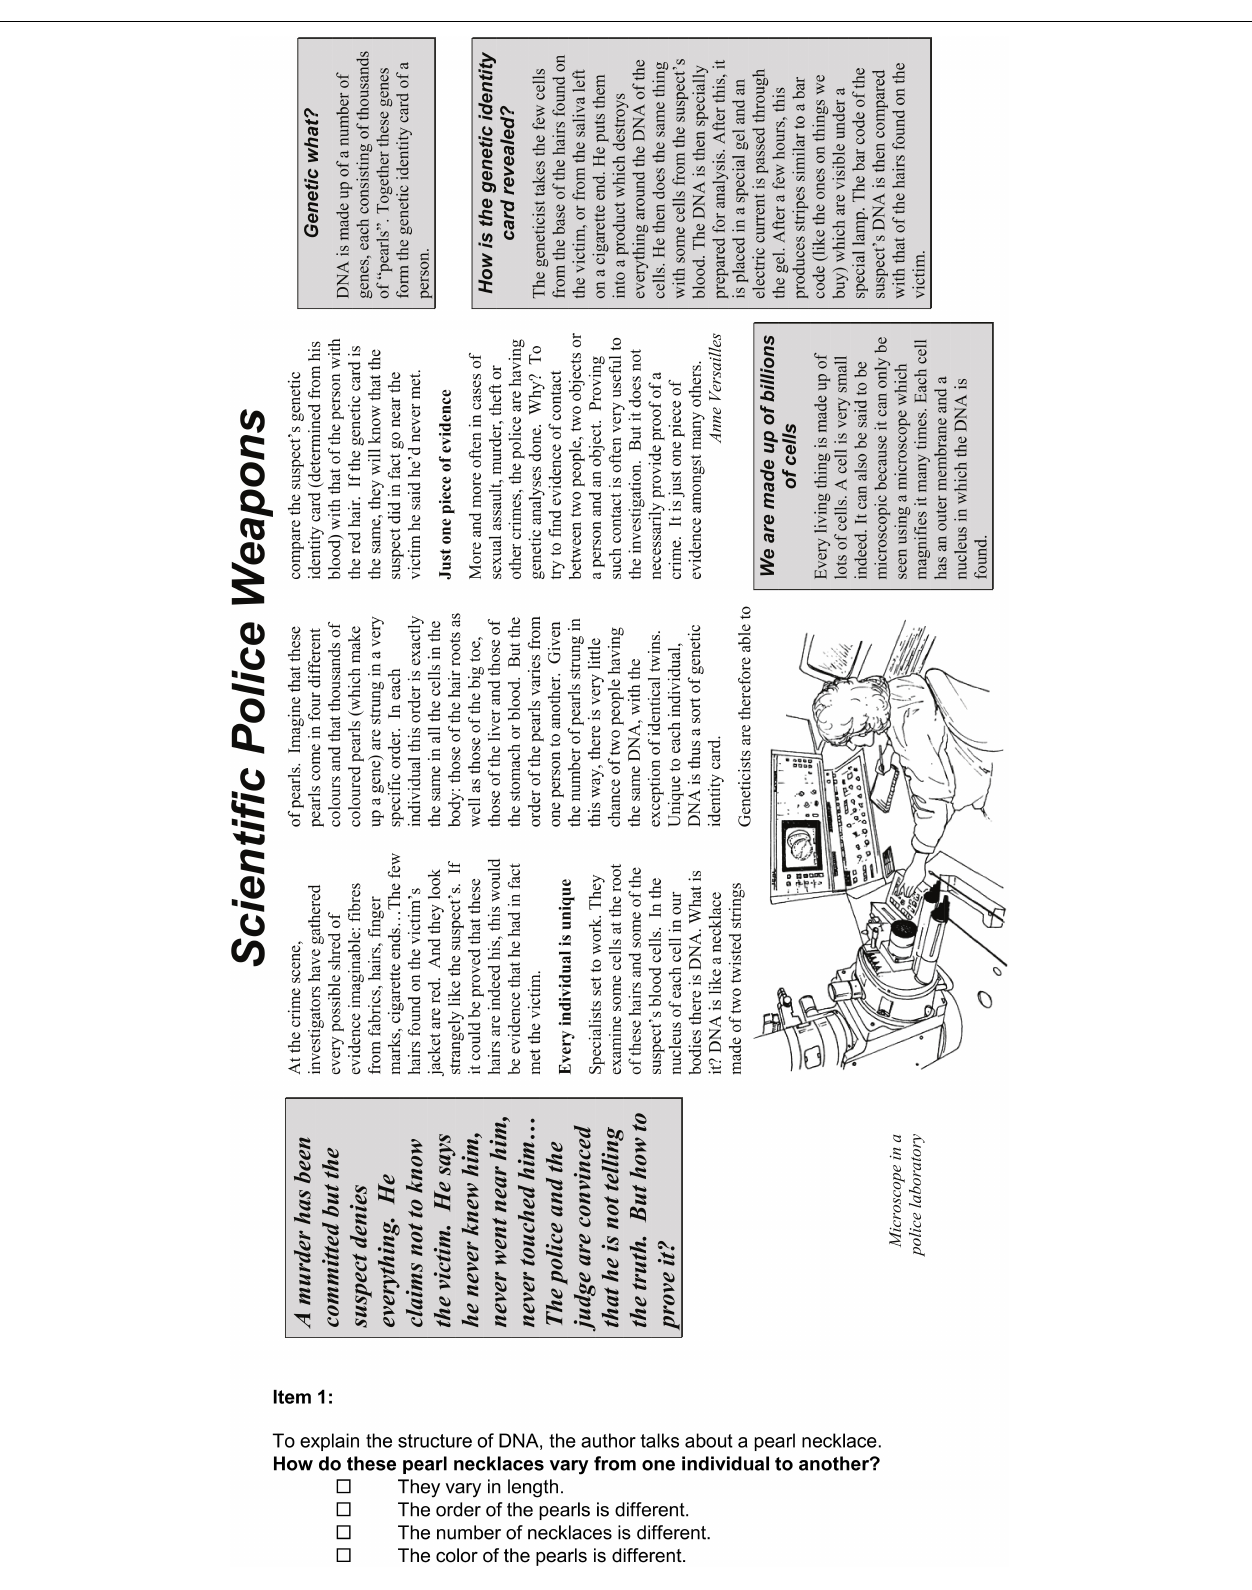
Frontiers in Psychology |